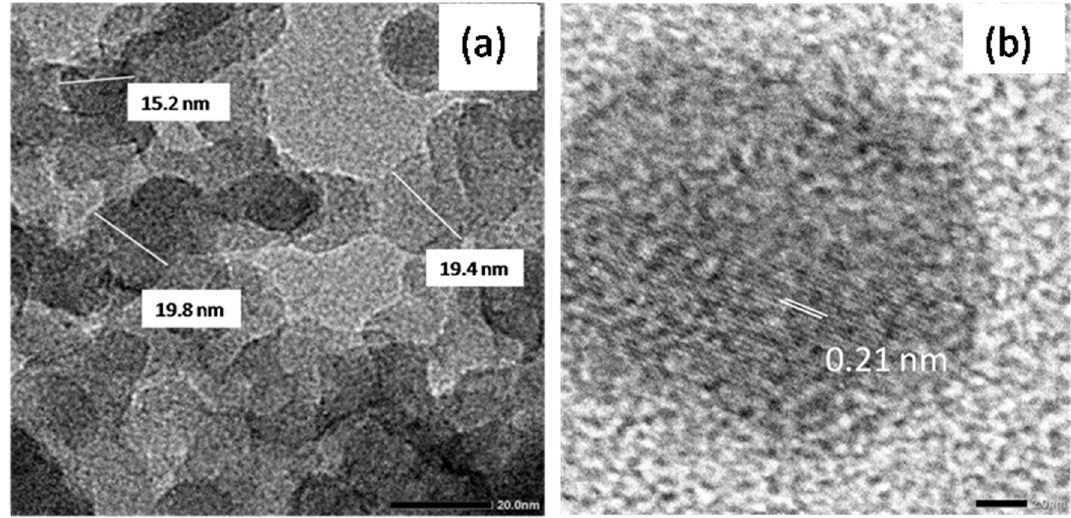
Figure 4. The high magnification TEM of the SiO 2 @Cu@CMC NPs ( a ) and HRTEM image of the SiO 2 @Cu@CMC NPs ( b ). The FTIR spectra of CMC, SiO 2 , SiO 2 @Cu NPs and SiO 2 @Cu@CMC NPs are shown in Figure 5. Figure 5a is the FTIR of SiO 2 NPs; the broad band near 3466 cm − 1 corresponded